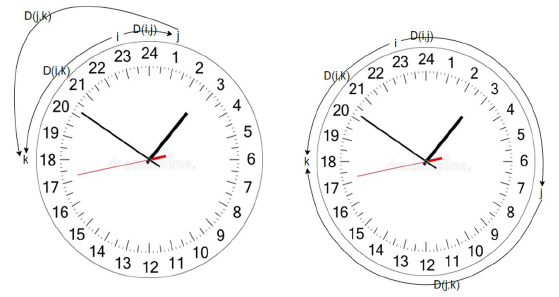
Figure 4. Illustration of the equation for satisfying the triangle